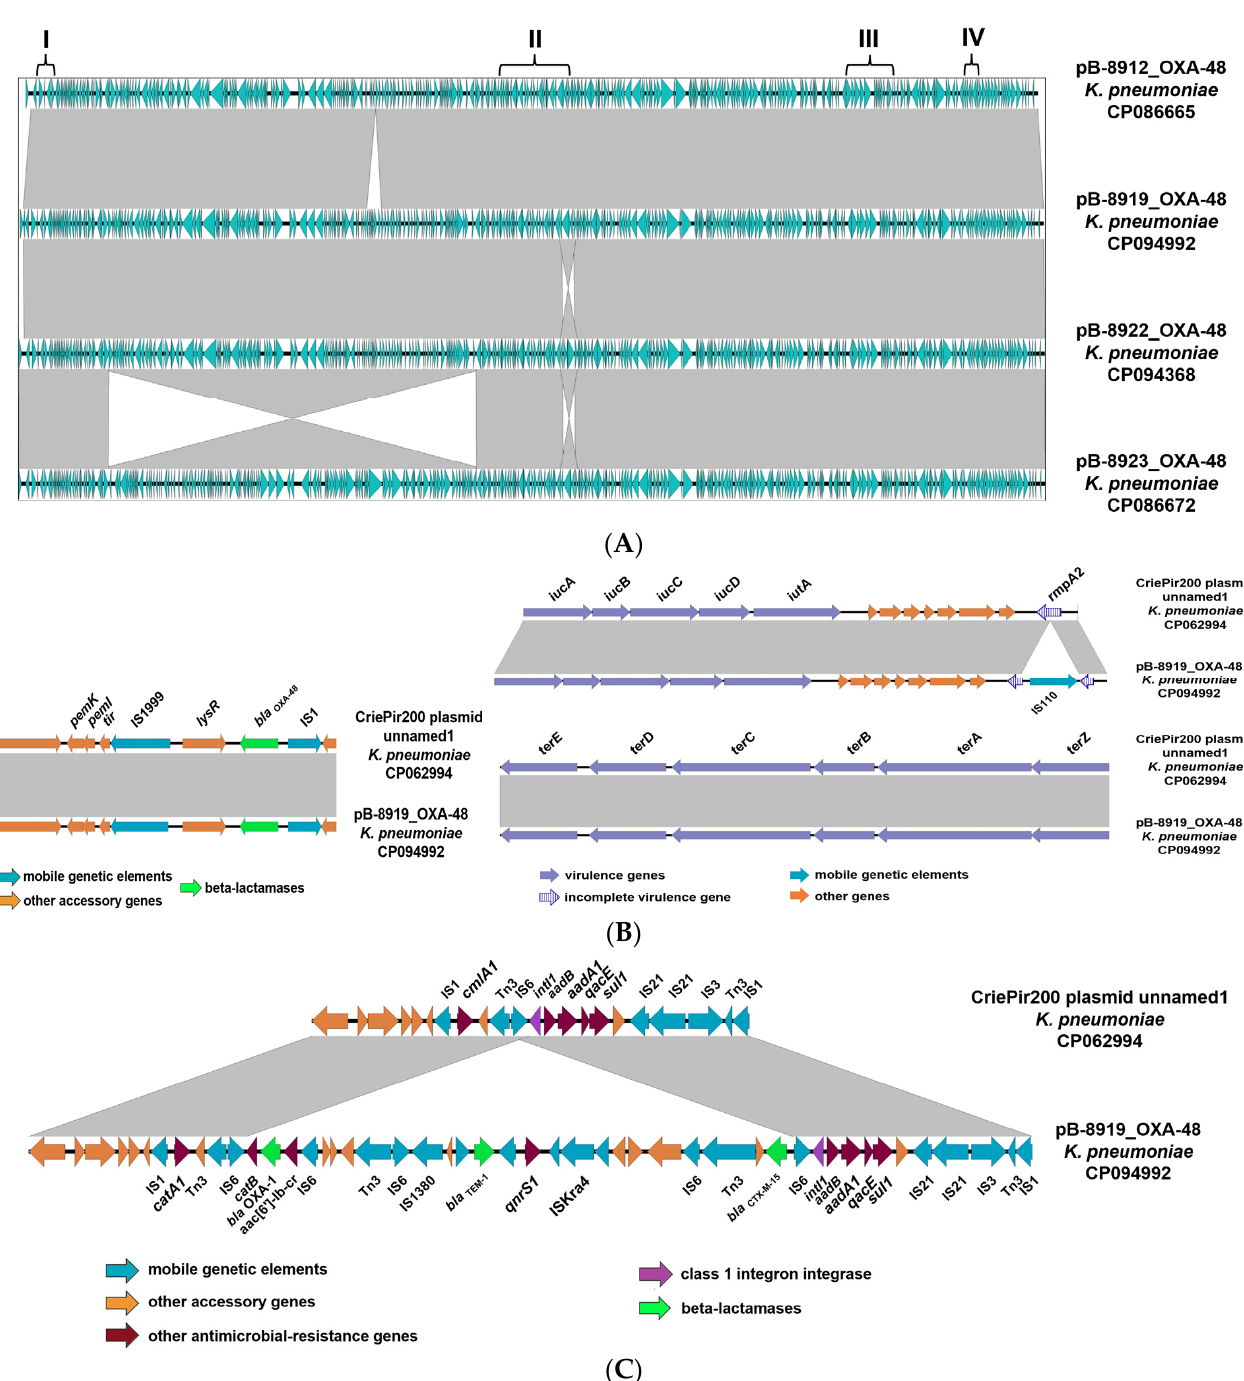
Figure 2. Easyfig comparison: ( A ) IncHI1B plasmid in four K. pneumoniae clinical strains carrying carbapenemase gene bla OXA-48 (region I), integron class 1 and beta-lactamase genes bla TEM-1 , bla CTX-M-15 , and bla OXA-1 (region II), virulence genes iucABCD, iutA, and rmpA2 (region III), and virulence genes terEDCDAZ (region IV); ( B ) genetic environments of the bla OXA-48 gene (region I) and virulence genes (regions III and IV); ( C ) genetic environments of beta-lactamase genes bla TEM-1 , bla CTX-M-15 , and bla OXA-1 (region II) in the plasmid pB-8919_OXA-48 of K. pneumoniae strain SCPM-O-B-8919 compared to the plasmid unnamed 1 of K. pneumoniae strain CriePir200 [37] The arrows show the open reading frames ( orfs ) and their